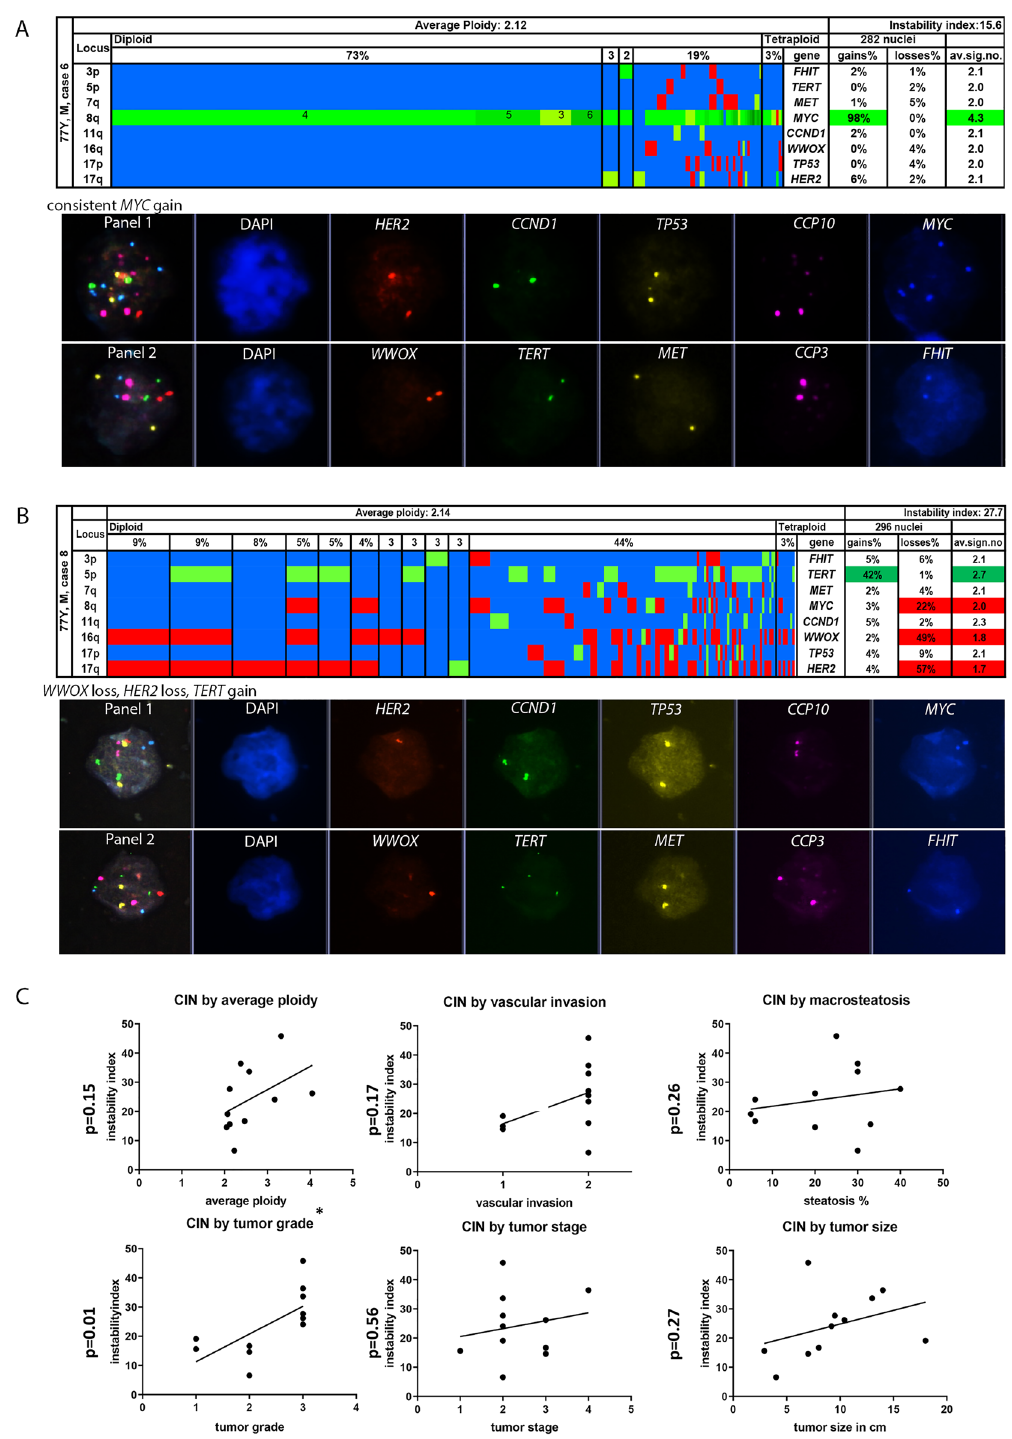
Figure 2. ( A – C ) Color display of miFISH analysis with eight gene-specific probes supplemented with a gallery view of signal patterns for representative nuclei in NASH-hepatocellular carcinoma cases. Copy number counts for each nucleus coded as follows: green, gains; red, losses; blue, unchanged. Detail from left to right: the “locus” column shows the chromosome arm the probes reside on. Cells with the same gain and loss patterns are grouped according to frequency and ploidy (vertical lines). The average ploidy (center, centromere signal/number of nuclei) and the instability index (top right, number of signal patterns/100 nuclei.) are calculated from all counted nuclei (296 and 282 respectively). ( A ) HCC case showing consistent MYC gain in 98% in diploid and tetraploid tumor cells (color figure) and relatively low instability index of 15.6 (number of signal patterns/100 nuclei). ( B ) HCC case with several tumor subclones, present in diploid and tetraploid cells, high instability index (27.7), due to different signal patterns comprising HER2 , WWOX loss and TERT gain. The loss of oxidoreductase WWOX and HER2 gains are potentially associated with NASH-induced hepatocellular carcinoma. DUET/SOLO acquisition and analysis software version 3.7.2.5 https:// biovi ew. com/ ( C ) Correlations of histopathological findings and chromosomal instability index with respective p-values (graphPad Prism software version 9.4.1 https:// www. graph pad. com/ scien tific- softw are/ prism/). CIN Chromosomal